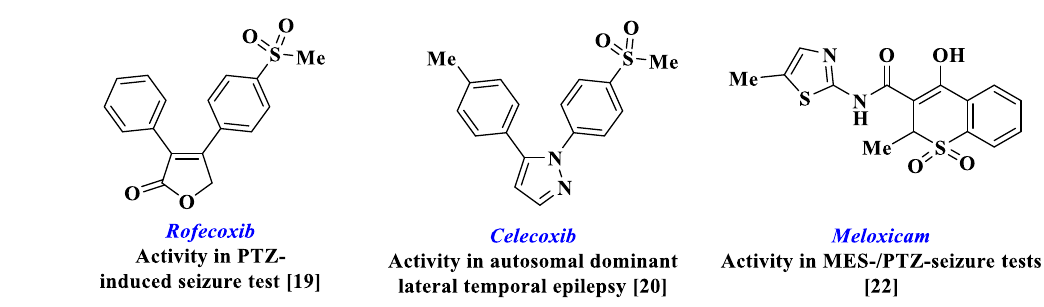
Figure 1. Anticonvulsant properties of marketed NSAIDs.